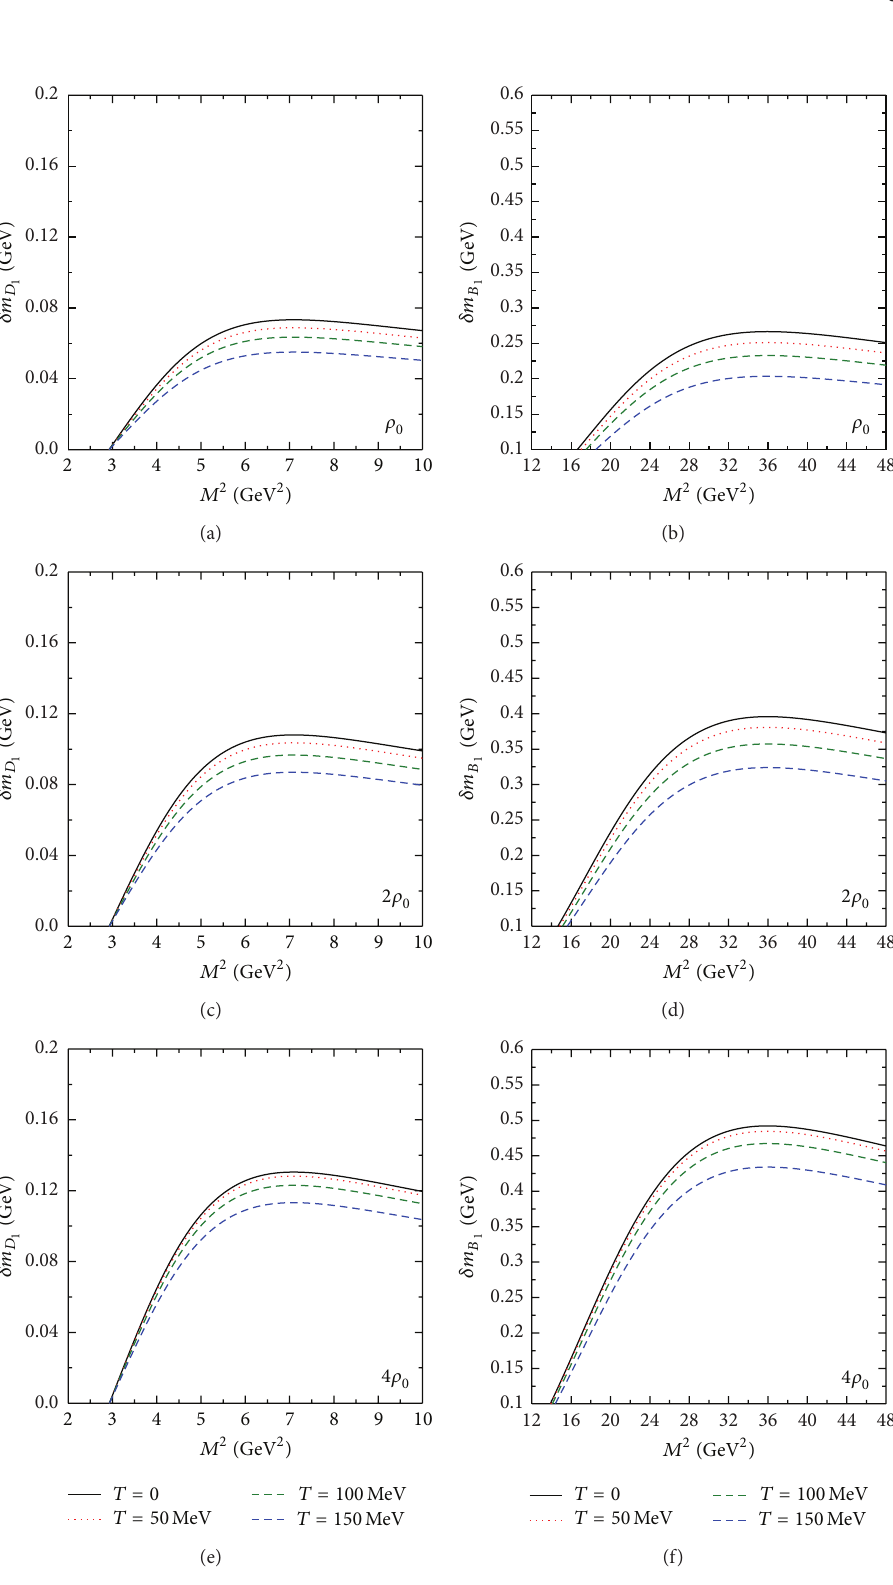
Figure 5: (Color online) Figure shows the variation of the mass shift of axial-vector mesons 𝐷 1 (subplots (a), (c), and (e)) and 𝐵 1 (subplots (b), (d), and (f)) as a function of the squared Borel mass parameter, 𝑀 2 . We have shown the results at baryon densities 𝜌 0 , 2𝜌 0 , and 4𝜌 0 . For each value of the baryon density the results are shown at temperatures, 𝑇 = 0, 50, 100, and